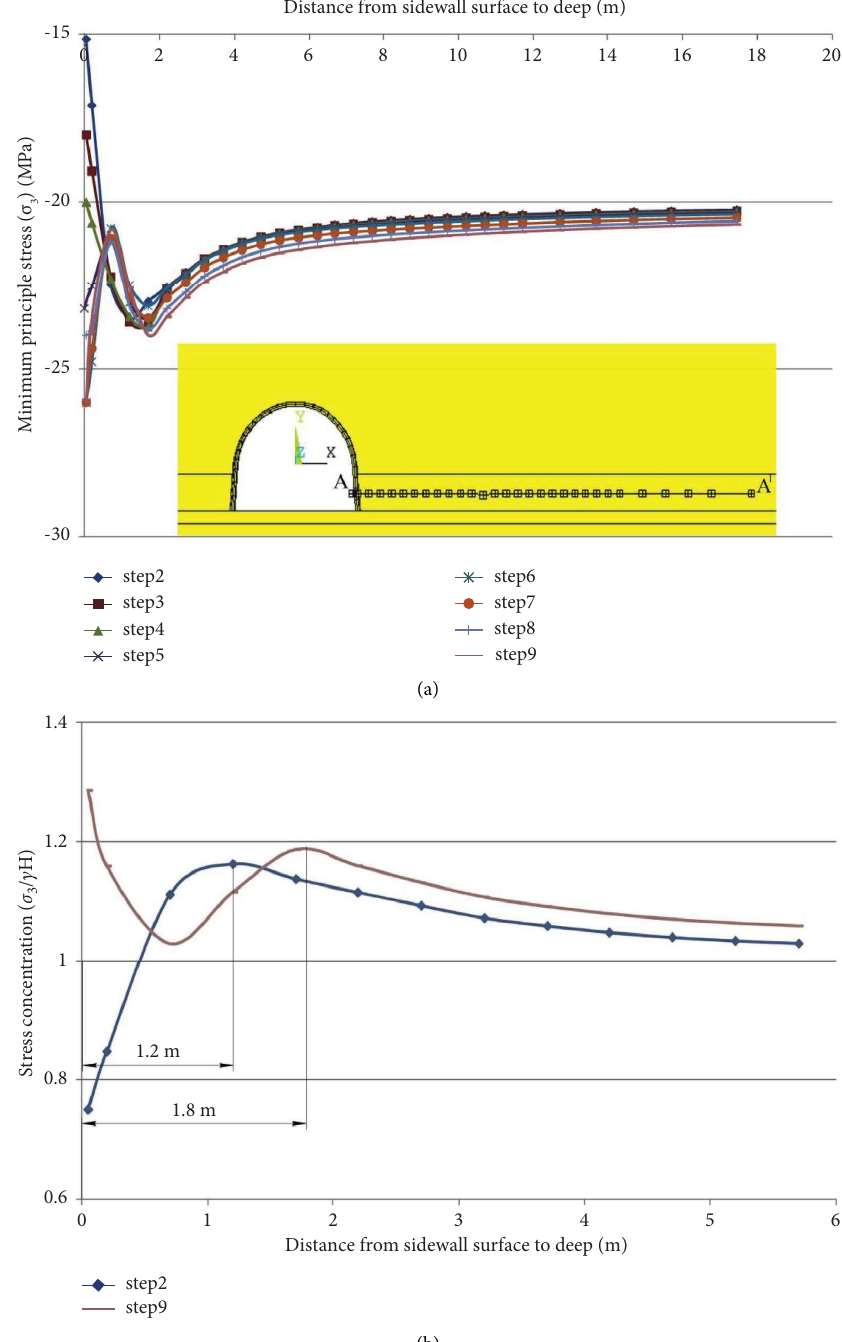
Figure 8: (a) Characteristics of minimum principle stress ( σ concentration factor ( σ 3 / c H ) on monitoring line A-A 1 for steps 2 and